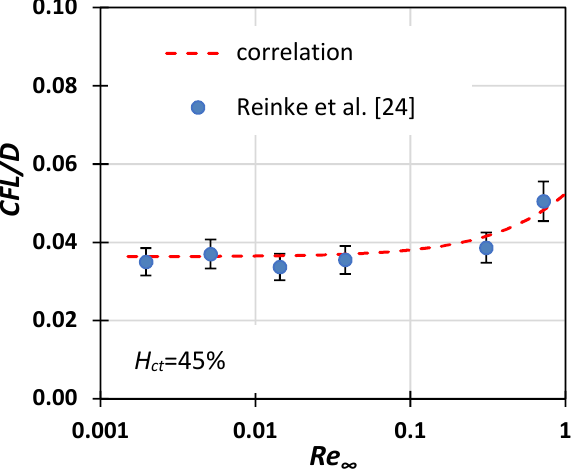
Figure 12. CFL thickness dependence on H ct and Re ∞ based on the proposed correlation (Equation (6)).